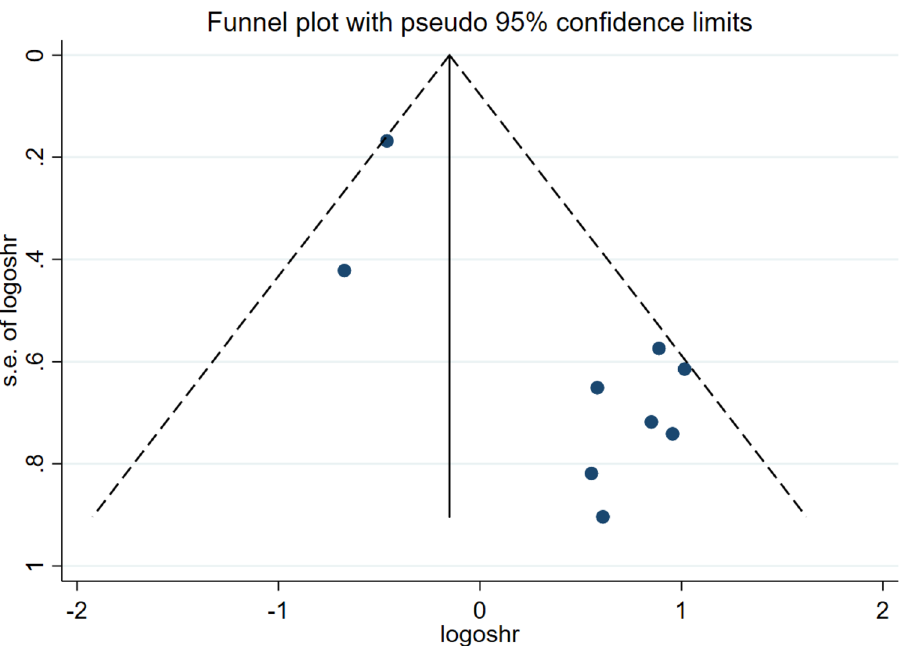
Figure 4. Funnel plot of publication bias related to the association between the expression of circRNAs and the prognosis of patients with BC.